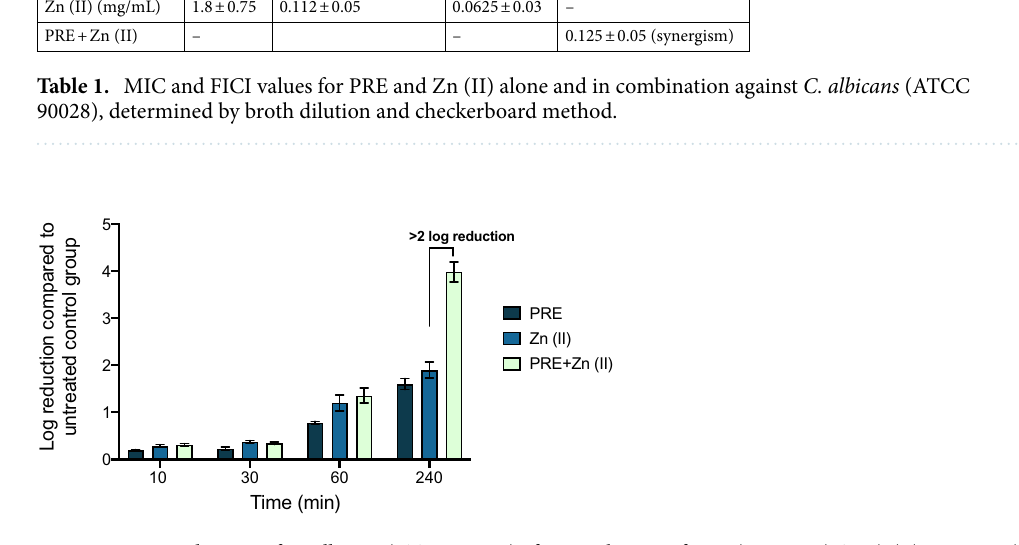
Figure 2. Log reduction of C. albicans (ATCC 90028) after incubation of PRE (4 mg/mL), Zn (II) (1.8 mg/mL), and PRE and Zn (II) (4 mg/mL + 1.8 mg/mL) in combination, over a range of contact times (10 min, 30 min, 60 min and 240 min) at 37